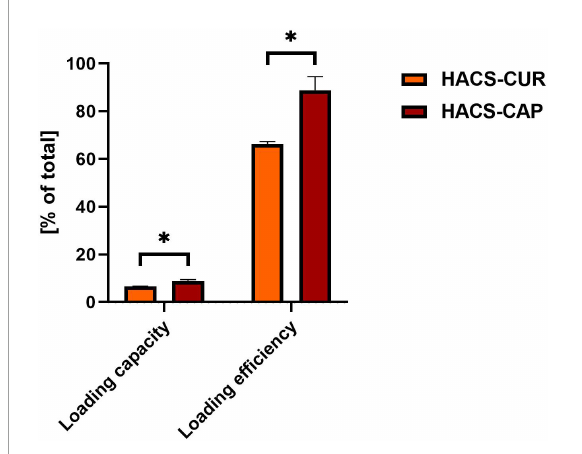
FIGURE5 HACS complexes loading capacity and loading efficiency with CUR or CAP. * p <